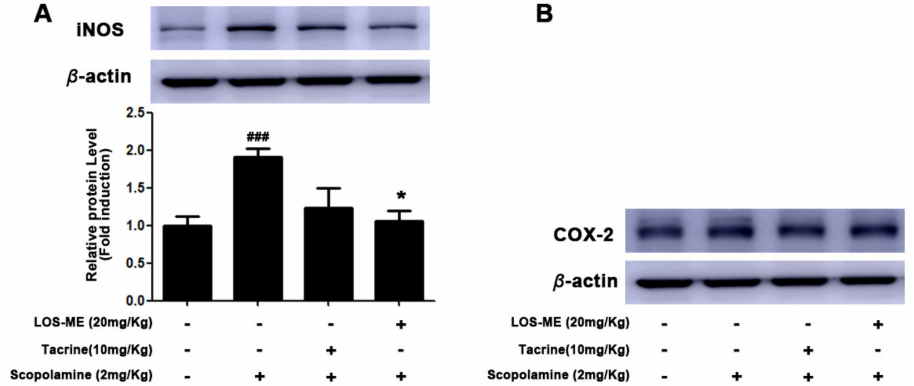
Figure 7. Effect of LOS-ME on iNOS and COX2 expression in scopolamine-induced mouse hippocam- pus. The hippocampal part of the mouse brain was isolated and confirmed by Western blot. ( A ) iNOS protein expression with corresponding fold change. ( B ) COX2 protein expression. β -actin was used as an internal control. Values are mean ± SD, n = 8, ### p < 0.001 as compared with control group; * p < 0.05 as compared with scopolamine-treated group by one-way